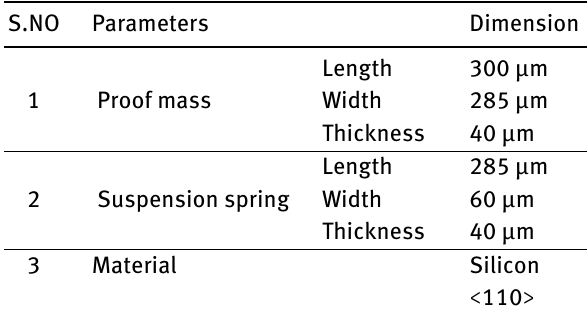
Table 1: Dimensions for parameter design